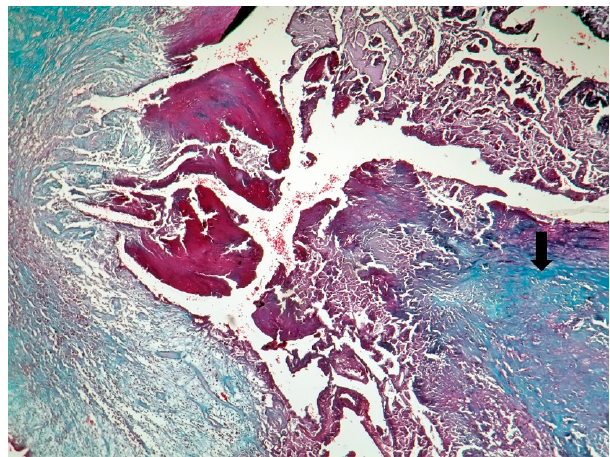
Figure 9. Fibrosis involving the valve and a part of the vegetation- arrow (Tricrom Masson stain × 5).